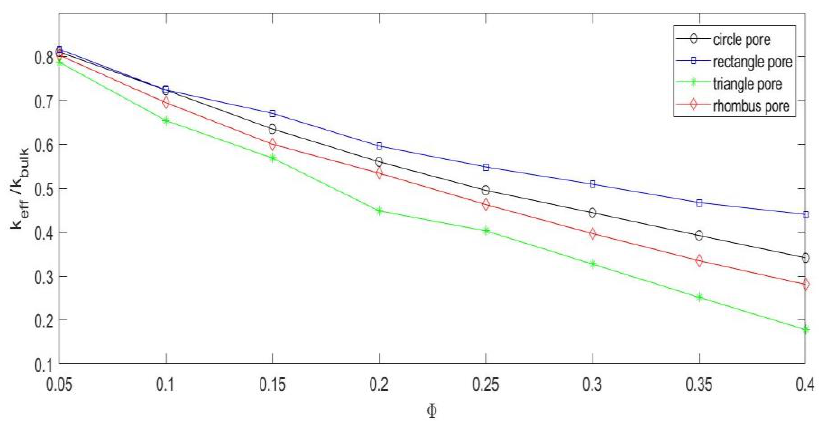
Figure 10. The effective thermal conductivity for four kinds of pore shapes at 300k, AlN.